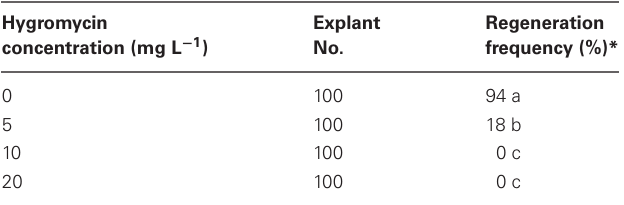
FIGURE 2 | Results of shoot regeneration from hypocotyl explants grown on the regeneration medium supplemented with hygromycin